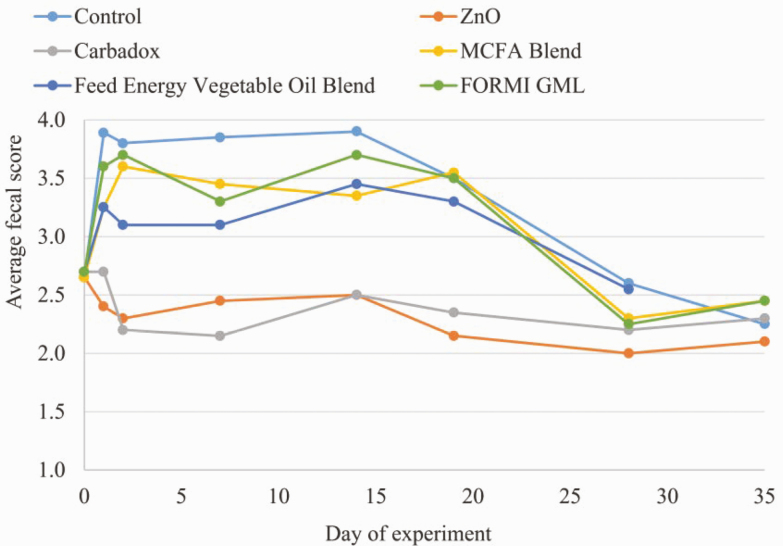
Impact of dietary treatment on fecal score. Fecal scoring was categorized as a numerical scale from 1 to 5 as follows: 1, hard pellet-like feces; 2, firm formed stool; 3, soft moist stool that retains shape; 4, soft unformed; and 5, watery liquid stool.